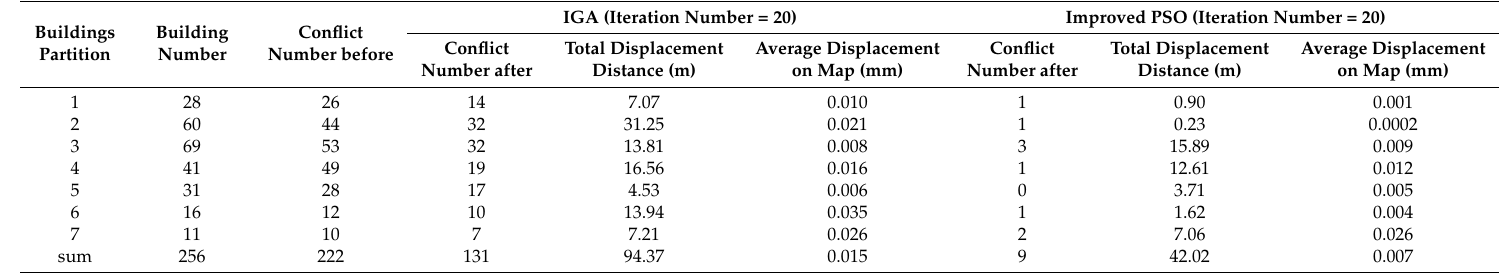
Table 3. Displacement results after 20